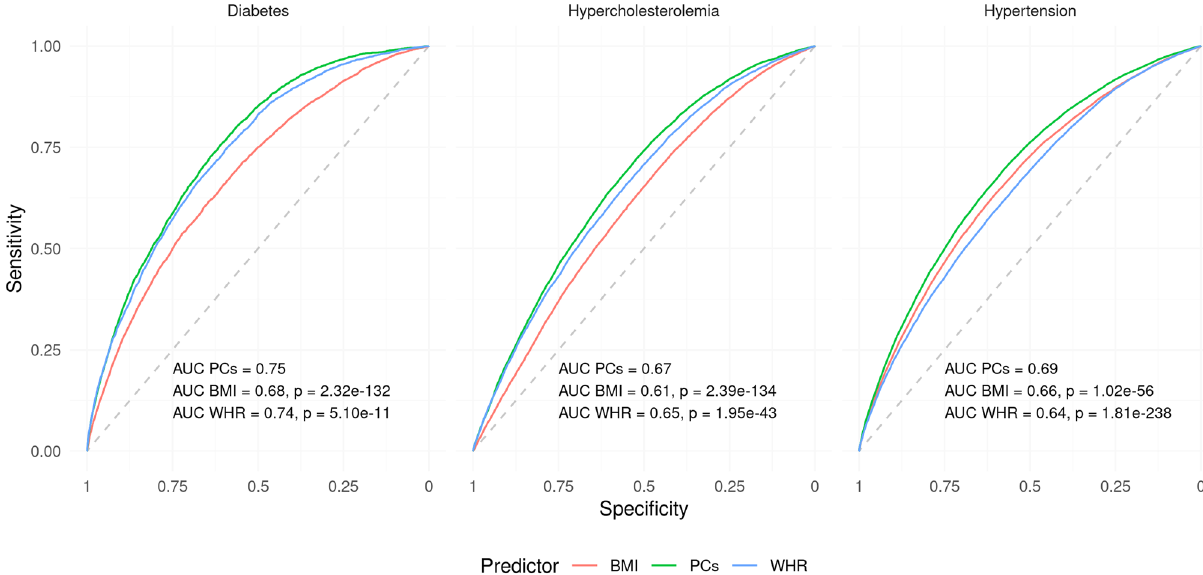
Fig. 6 Principal components (PCs) improve prediction of obesity-related diseases out-of-population. Receiver operating characteristic (ROC) curves for PC-, BMI-, and WHR-based prediction of diabetes, hypercholesterolemia, and hypertension out-of-sample/-population. The indicated p -values for the difference between the PC- and single trait-based curves were obtained using the DeLong method. AUC area under the